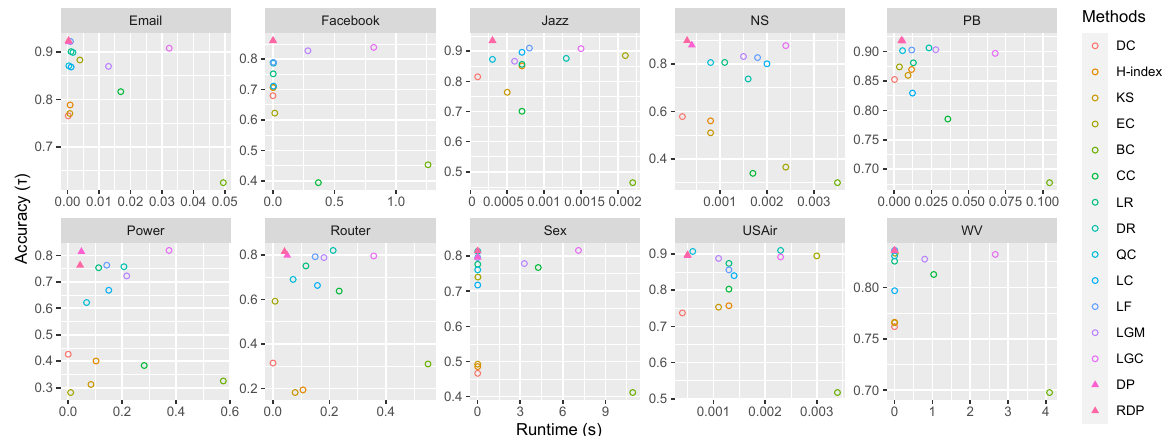
Figure 4. Comparison of runtime and accuracy on ten